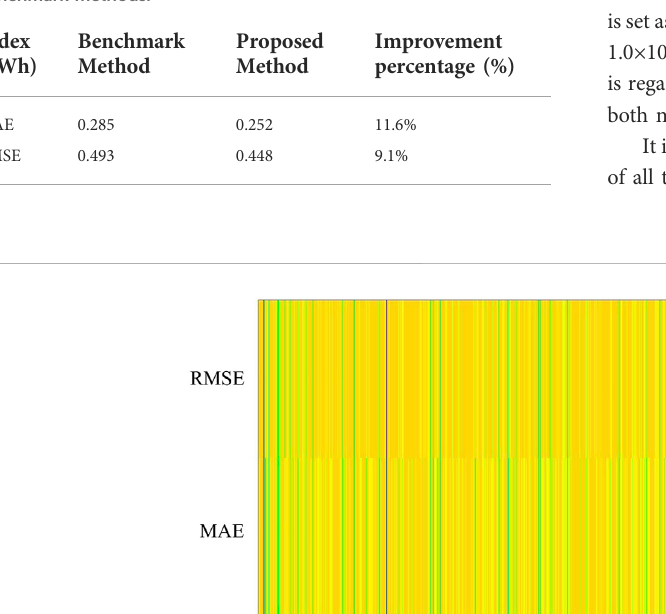
TABLE 3 Residential load forecasting results of the proposed and benchmark methods.